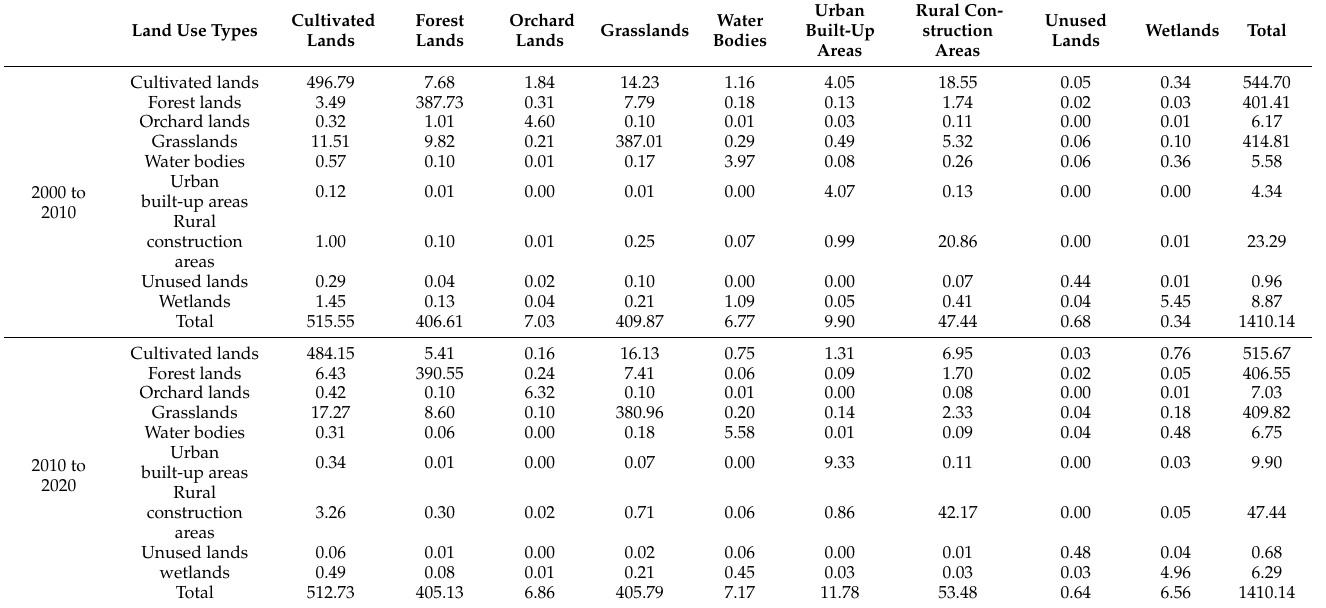
Table 4. Land use conversion area (10 4